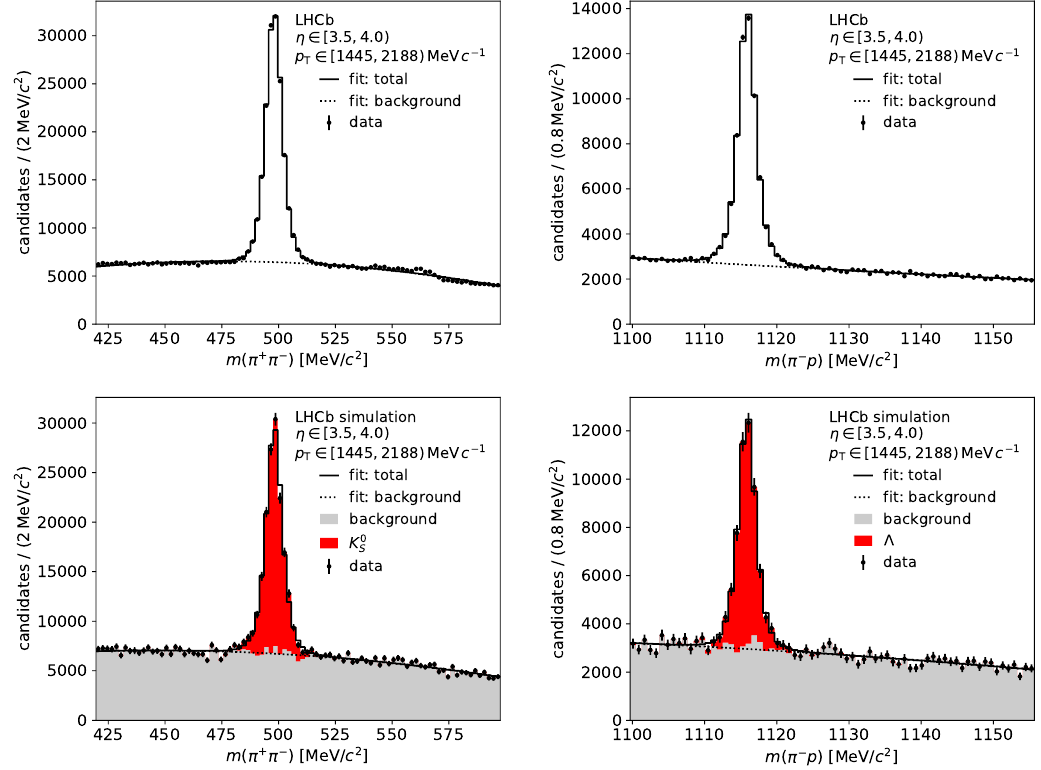
Figure 7 . Mass distributions of (left) K 0 and (right) Λ candidates in one kinematic interval for S (top) the LHC fill recorded with the magnetic field pointing upwards and (bottom) the simulated sample with the same magnetic-field configuration. Solid lines indicate the total fit and dotted lines the background. In the case of simulation, the signal and background contributions are shown for illustration, but this information is not used in the